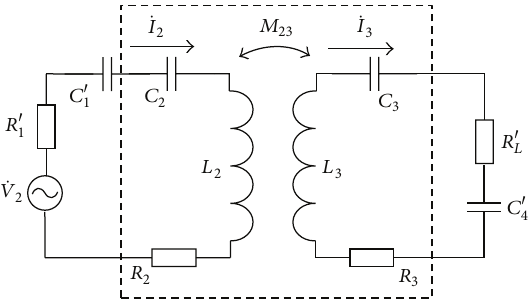
Figure 2: Double-coil equivalent circuit of a resonant